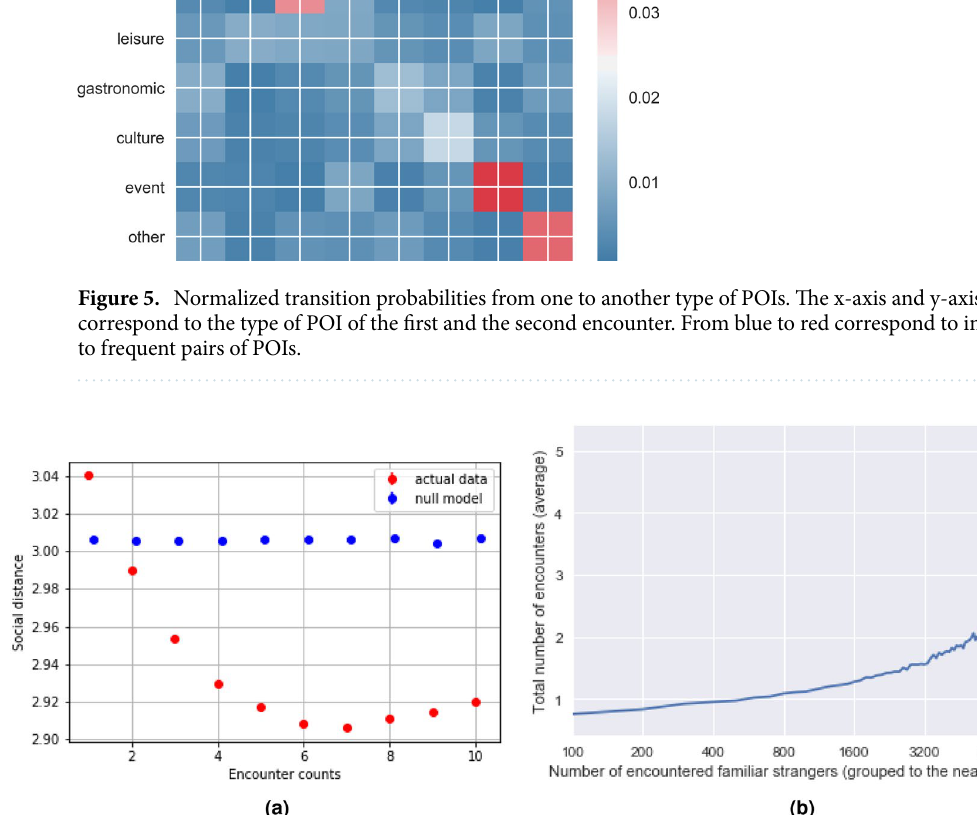
Figure 6. ( a ) Relationship between the number of encounters and social distances in social networks of familiar-stranger pairs. In the left panel, the x-axis is the number of encounters for each familiar-stranger pair. The y-axis is the average social distance of the corresponding number of encounters. The red and blue points correspond to the real and the shuffled data. ( b ) In the right panel: the x-axis shows the number of familiar strangers and has been grouped to the nearest hundred and shown on a log scale to highlight the increasing trend. The top 1% of encountered counts have been removed in an attempt to remove anomalous